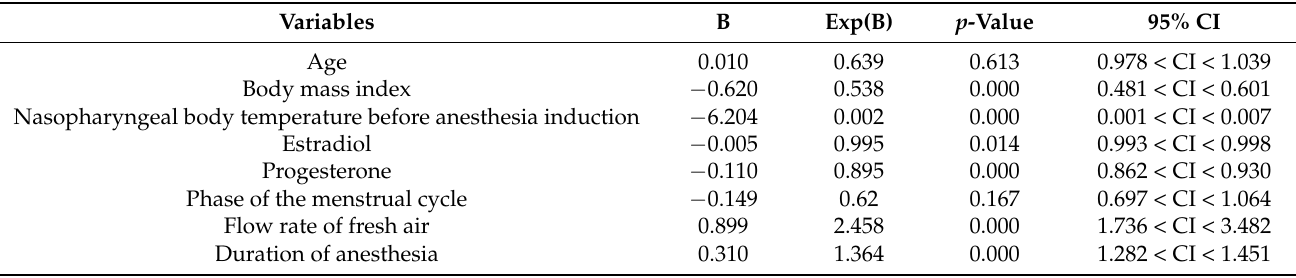
Table 5. Binary logistic regression analysis of risk factors for inadvertent intraoperative hypothermia before matching.